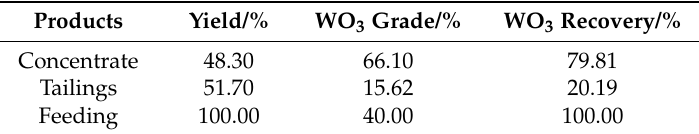
Table 1. Flotation results from mixed minerals.